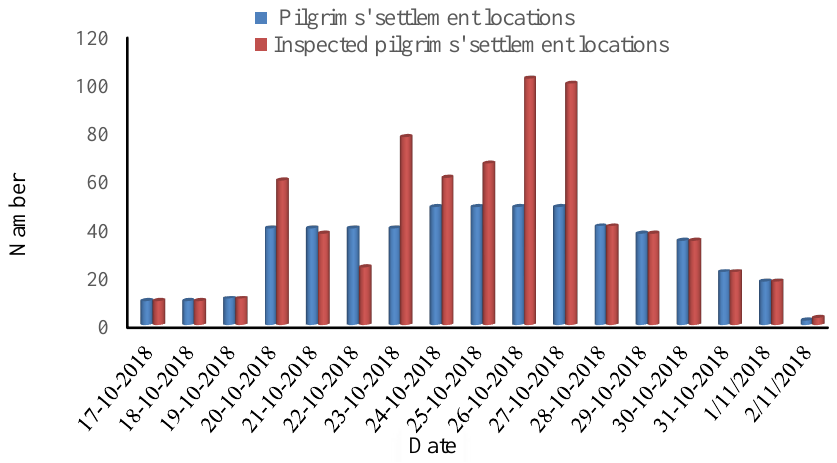
Fig. 3. Total number of pilgrim accommodations and inspections per